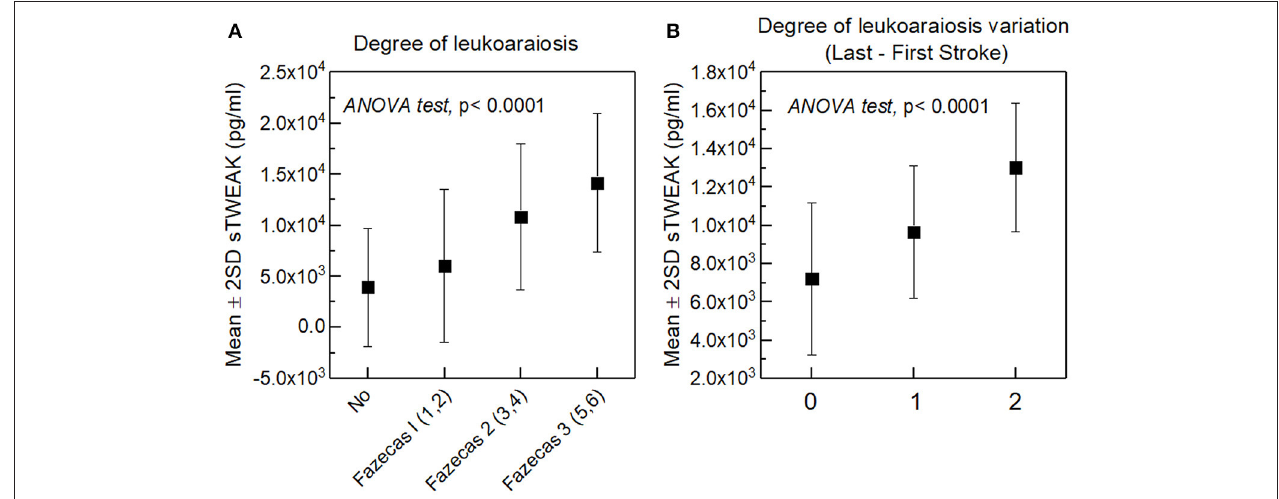
FIGURE 4 | (A) Relationship between sTWEAK levels and LA severity at first admission. (B) Relationship between sTWEAK levels measured in the last stroke and the variation between the degree of LA found in the last stroke in relation to the first.